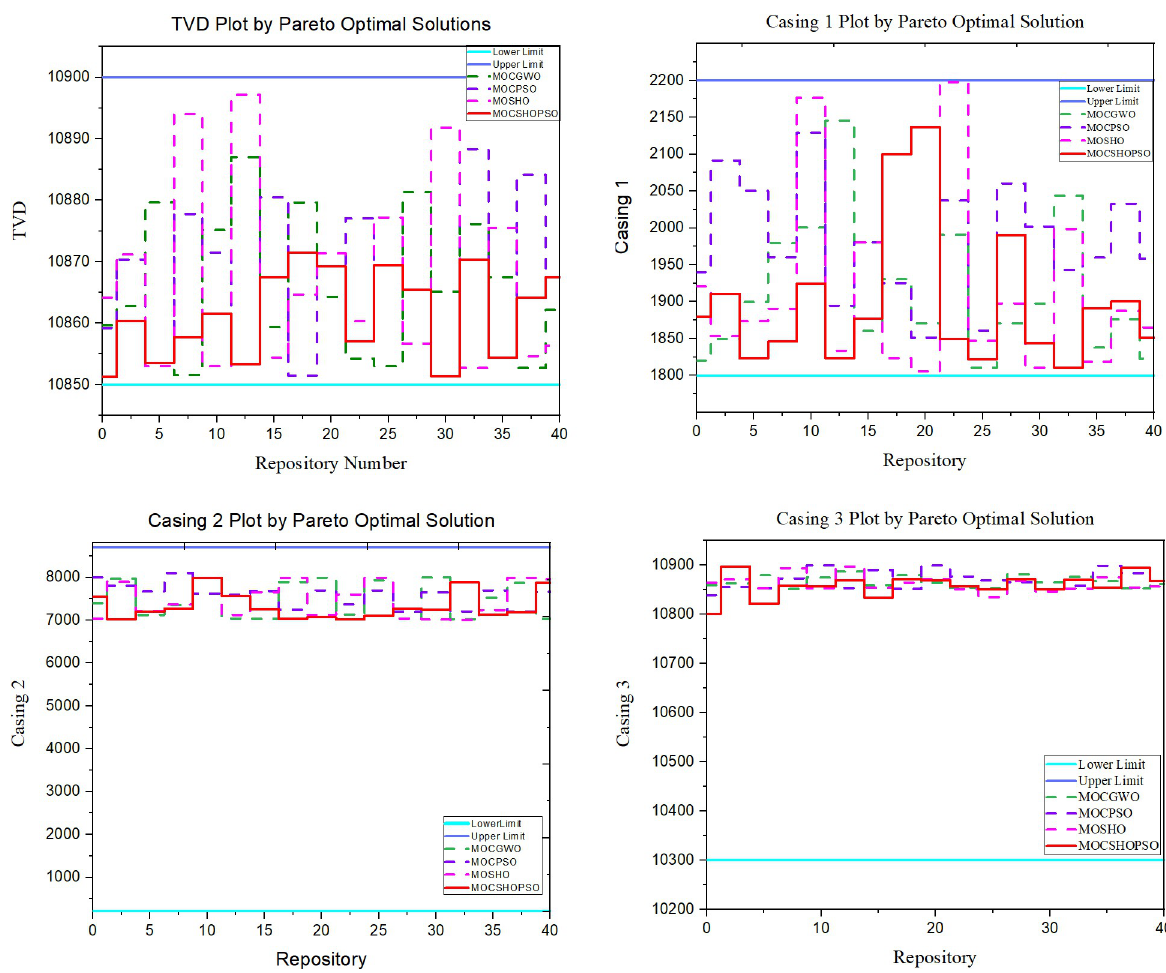
Fig 10. Comparison plot for operational constraints. (a) TVD. (b) Casing 1. (c) Casing 2. (d) Casing 3.